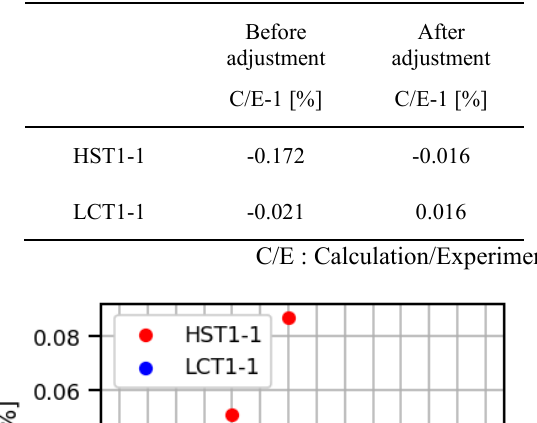
Table 3. Changes in C/E-1 values of criticality with cross-